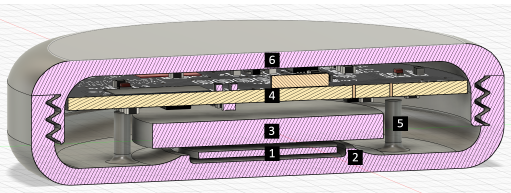
Figure 8. Cross-section of the sensor node. 1: wireless charging coil, 2: offsets, 3: battery, 4: PCB, 5: support pins, 6: twist top.